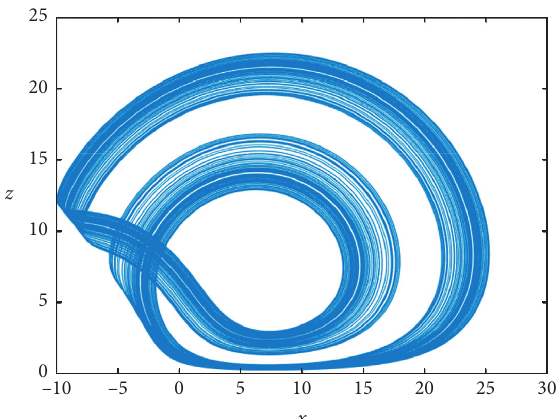
Figure 23: Dynamics of the fractional-order system in (13)–(15) with the order α � 0 . 92, in context of x and z directions.